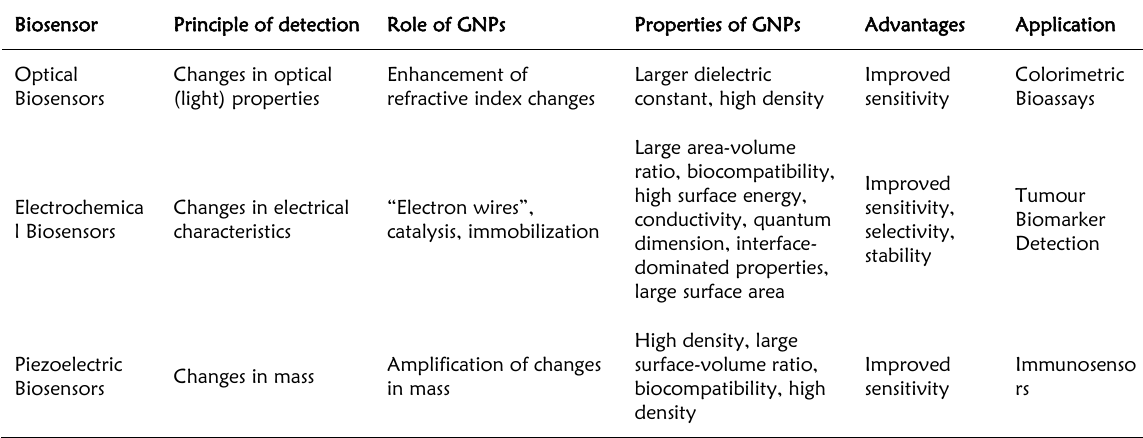
Table 1: Summary of the GNP based biosensors